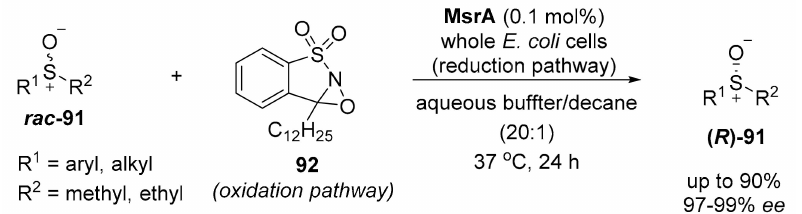
Scheme 24. Deracemization of chiral